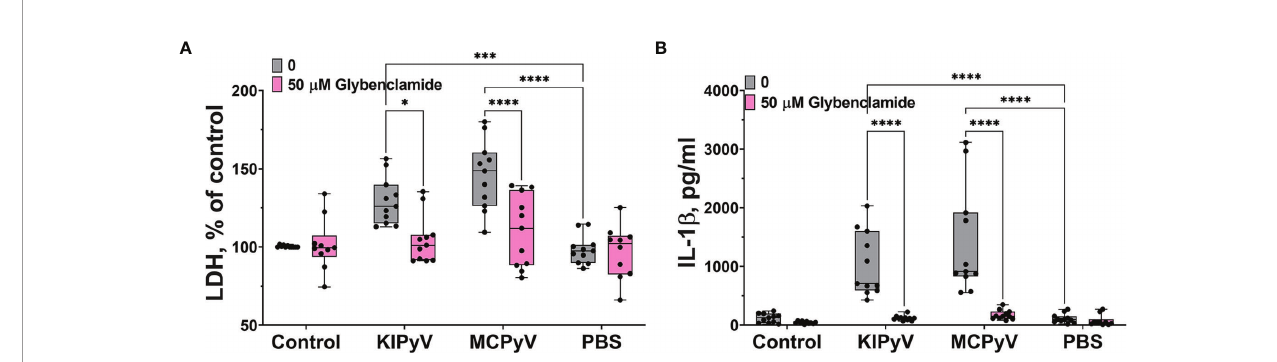
FIGURE 6 | K + ion ef fl ux inhibitor reduced PyV VLP-induced cell death and IL-1 b release in human THP-1 macrophages. Macrophages were treated with PyV- derived VLPs (20 µg/ml) for 24 h Inhibitor glybenclamide (50 m M) was added 30 min before treatment. (A) Cytotoxicity assessed by LDH assay. (B) IL-1 b secretion determined by ELISA. Data are represented using box plots with dots showing independent experiments, * p < 0.05, *** p < 0.001, **** p < 0.0001, one-way ANOVA followed by Tukey ’ s multiple